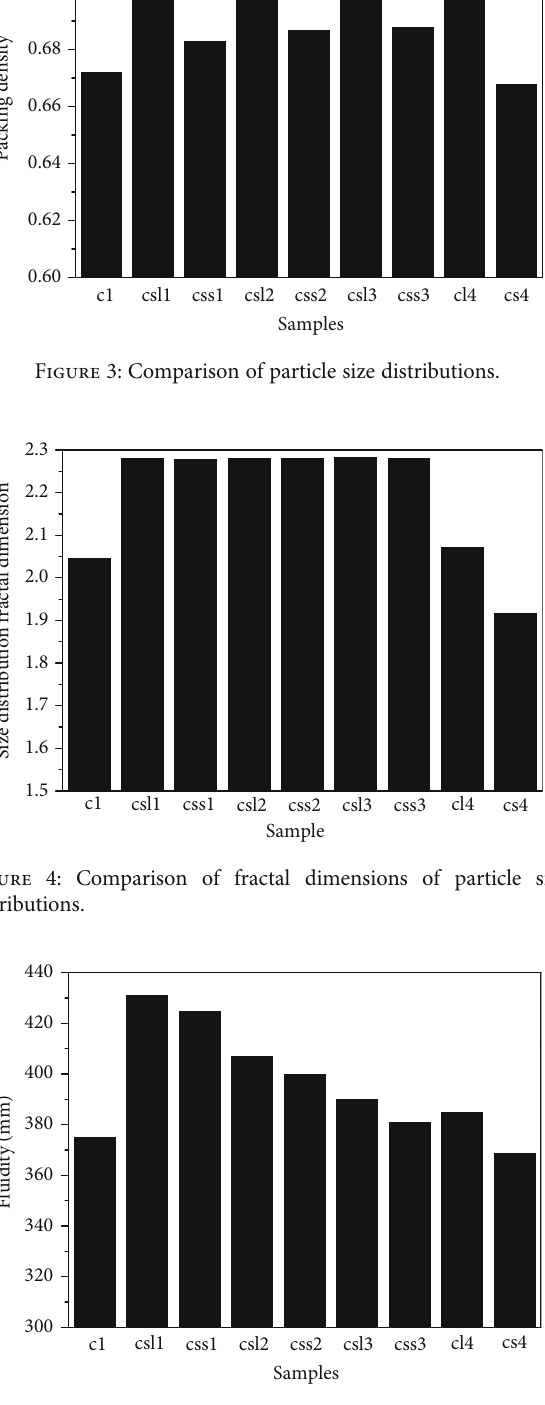
Figure 5: Comparison of fl uidities.